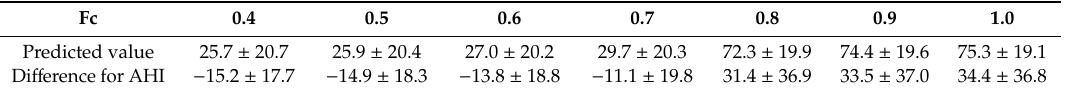
Table 2. Detection values with di ff erent Fc values.